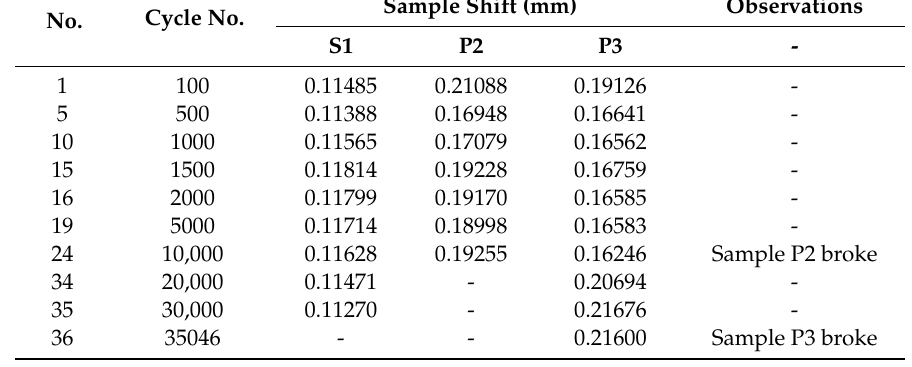
Table 1. Number of testing cycles for S1, P2, and P3.